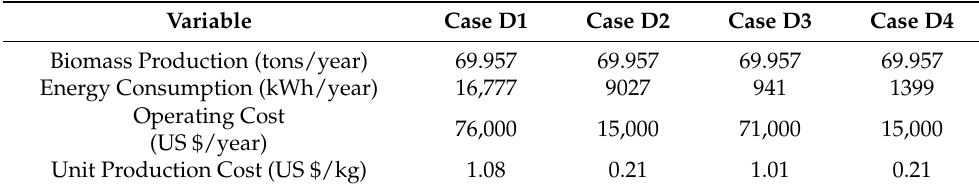
Table 4. Summary of Results for Secondary Harvest (Centrifugation and Filtering).